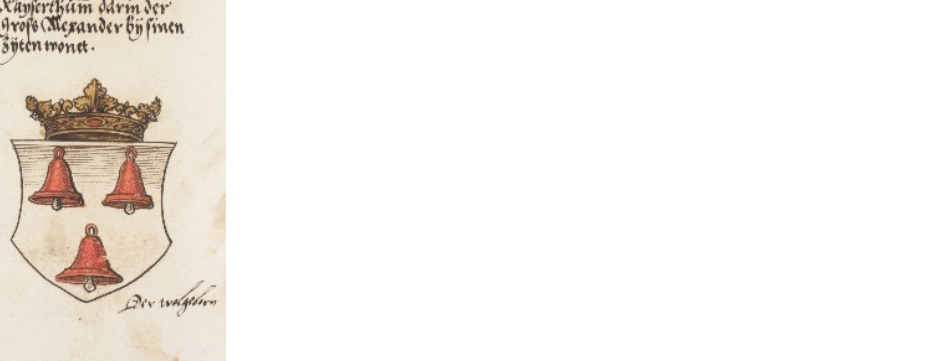
Figure 15. CoA of the king and kingdom in the time of Alexander the Great, Chronicon